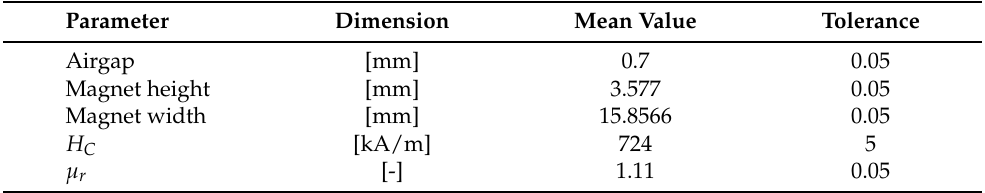
Figure 12. The geometrical parameters, which tolerances were considered during the analysis. Table 2. The varied parameters during the tolerance analysis with their mean values and the applied tolerances.